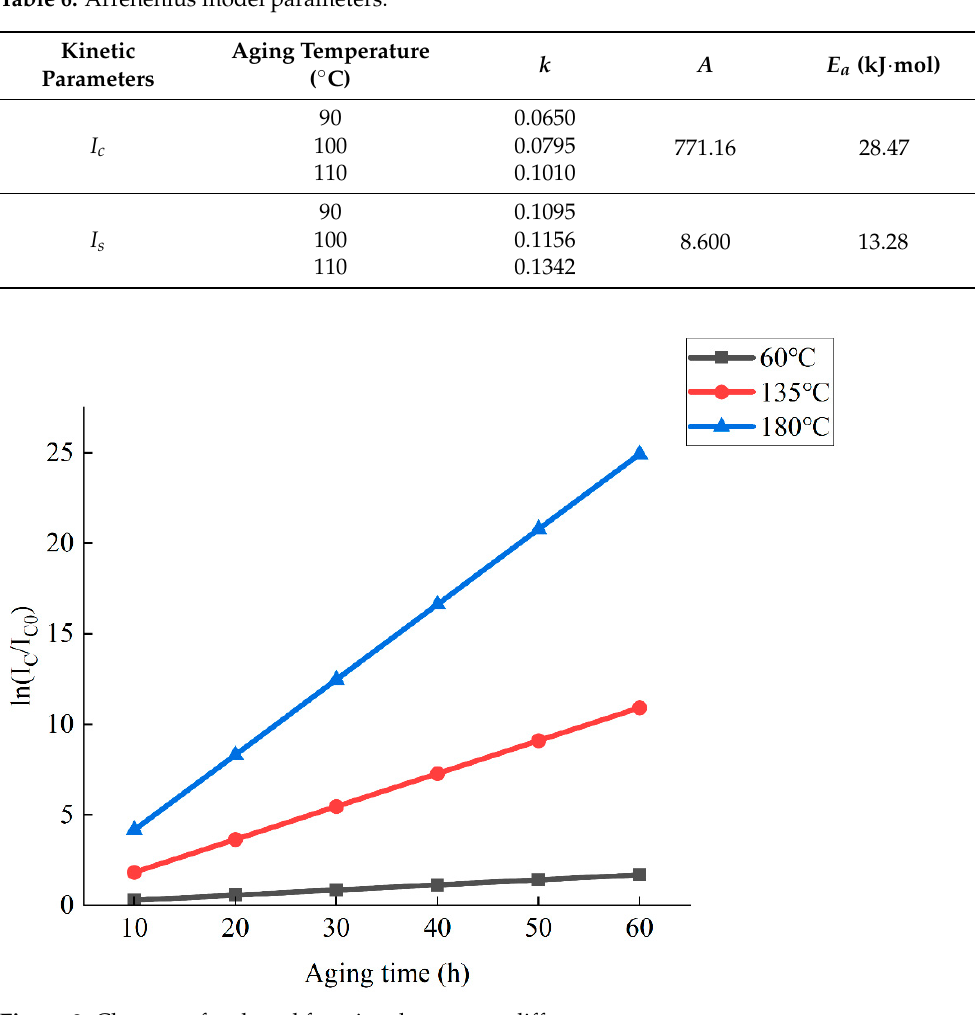
Figure 9. Changes of carbonyl functional groups at different temperatures.